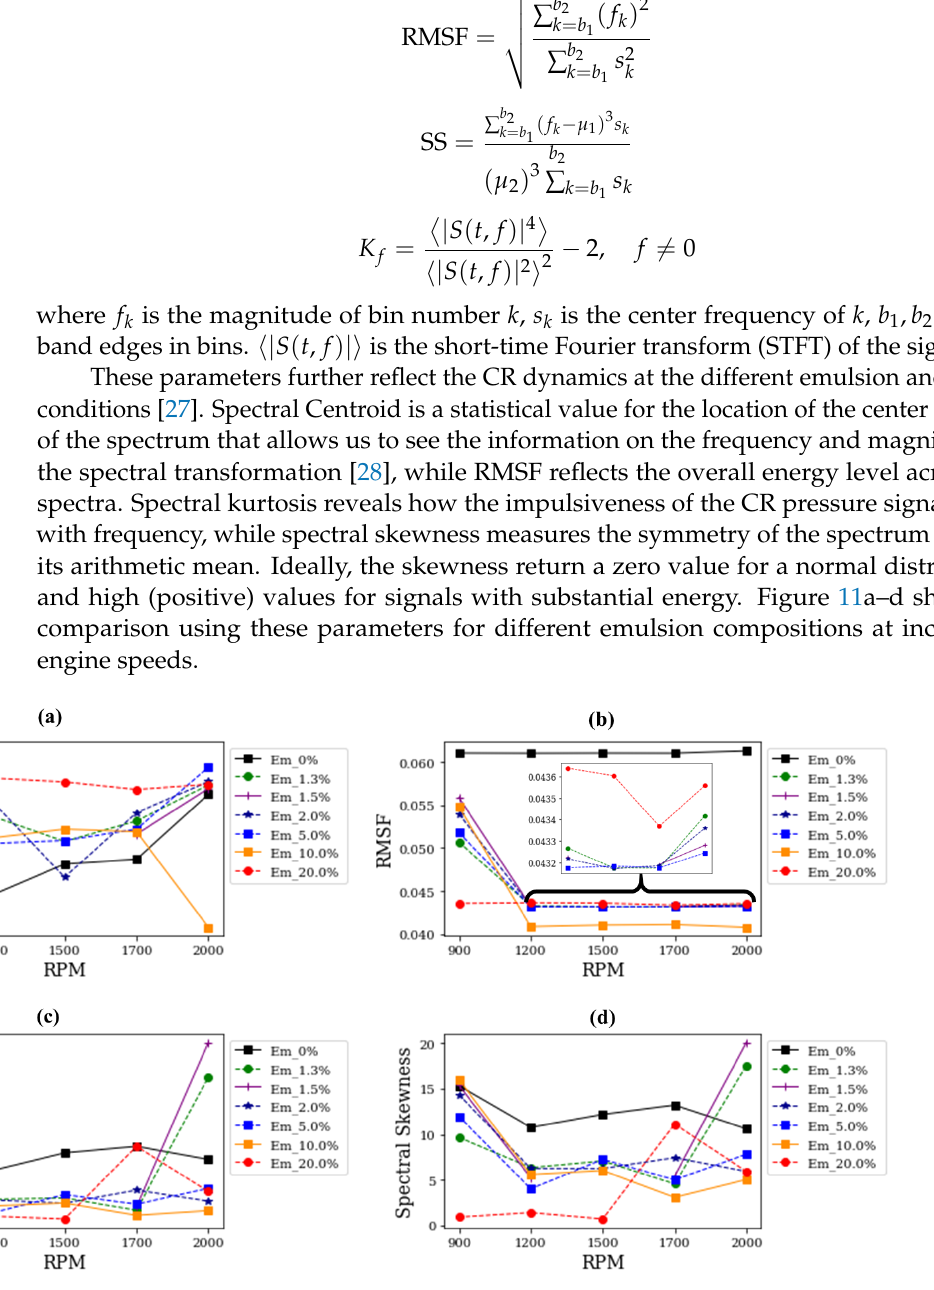
Figure 11. Spectral parameters of CR pressure differentials for different emulsion compositions ( a ) spectral Centroid, ( b ) RMSF, ( c ) Spectral kurtosis, and ( d ) Spectral